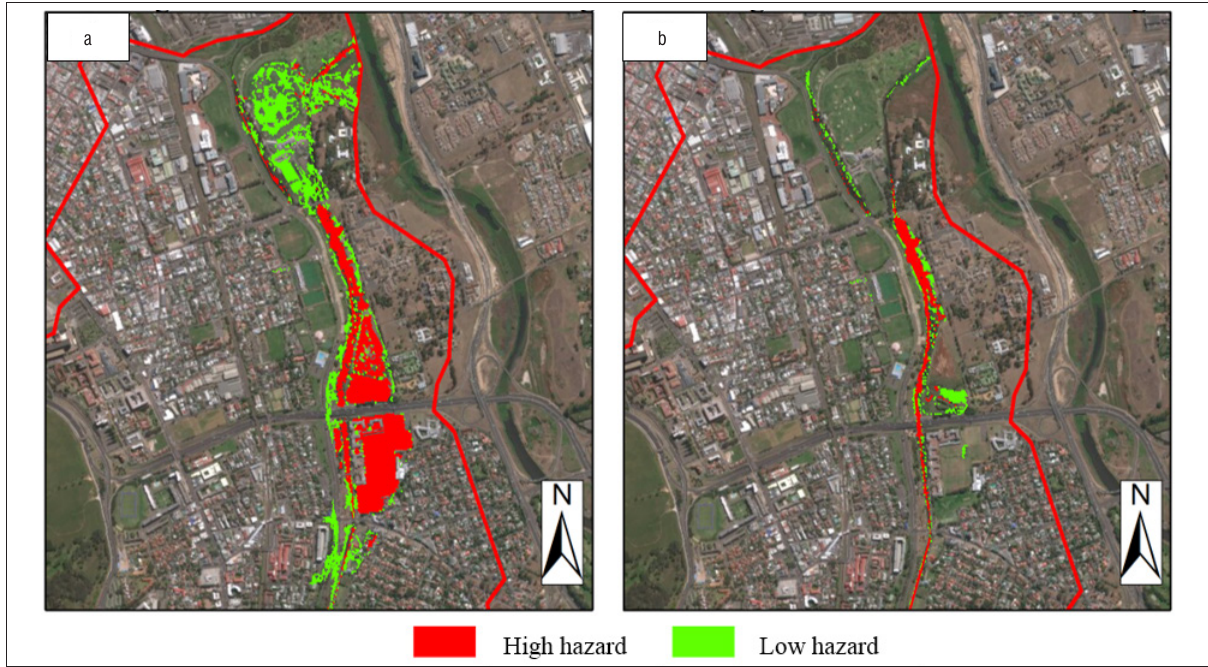
Figure 1: Flooding in the Liesbeek River Catchment on 12 July 2009 shown (a) without and (b) with stormwater harvesting.